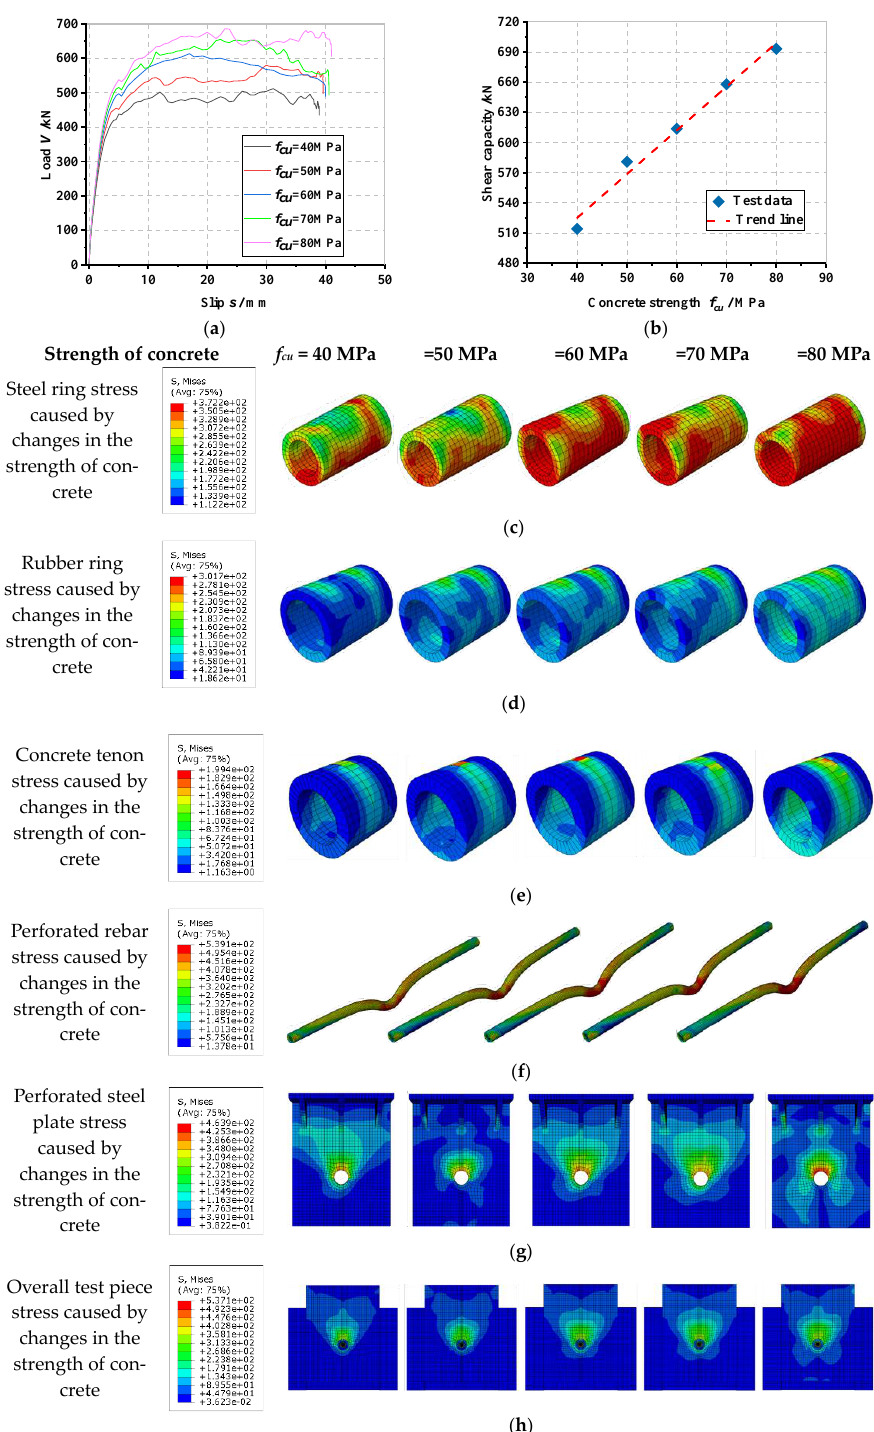
Figure 13. Influence of concrete strength: ( a ) overall load – slip curves, ( b ) impact analysis, ( c ) steel ring stress, ( d ) rubber ring stress, ( e ) concrete tenon stress, ( f ) perforated rebar stress, ( g ) perforated steel plate stress, ( h ) overall stress in the specimen.